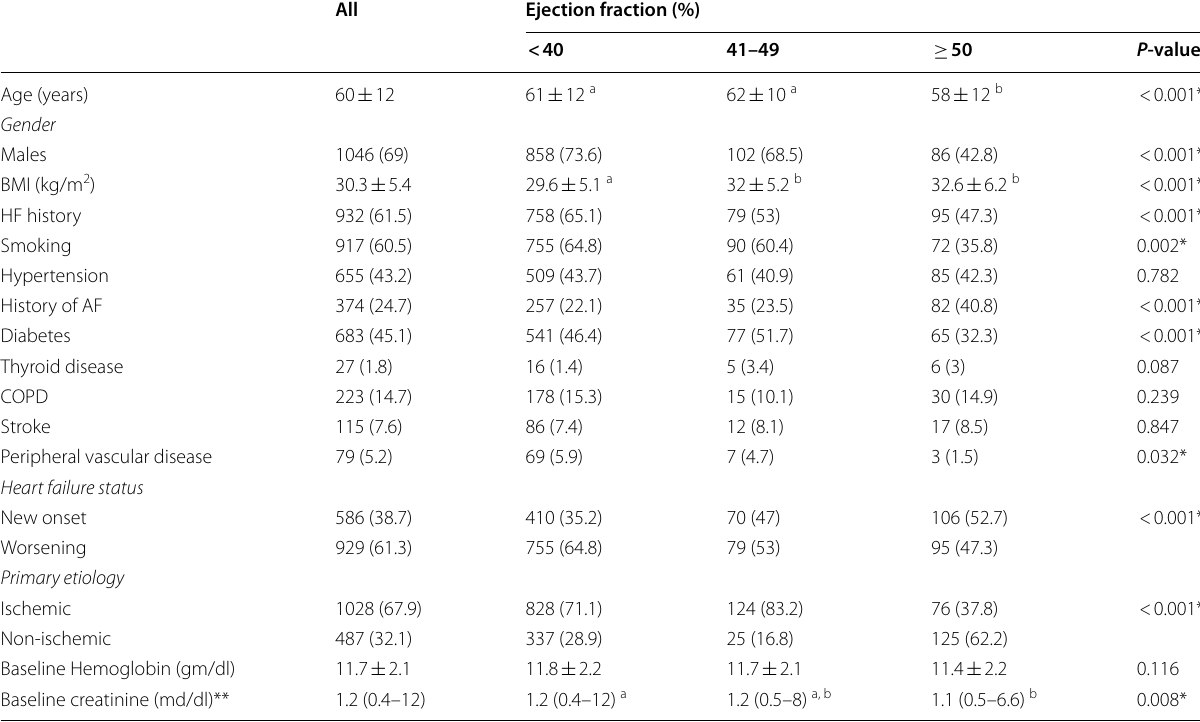
Data were presented as mean SD or number (percentage); Different superscripted letters indicate statistically significant differences between both groups; * Asterisk ± indicates an overall significant difference; ** presented as median (range) BMI Body mass index; AF Atrial fibrillation; HF Heart failure; and COPD Chronic obstructive pulmonary = = = =